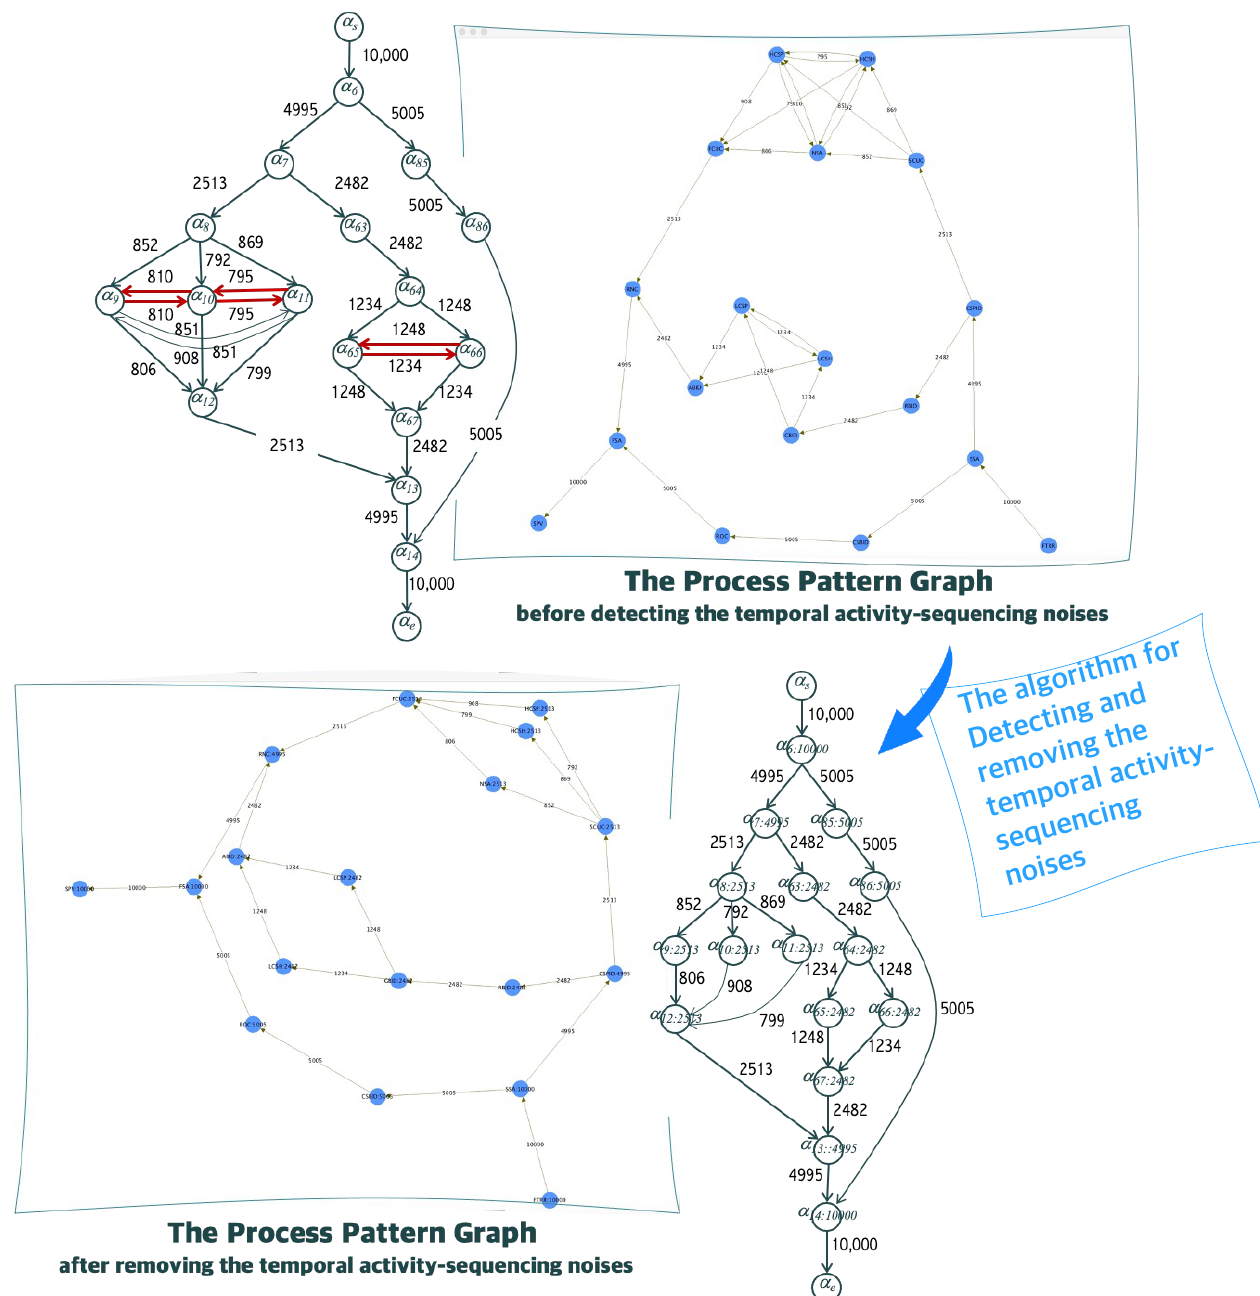
Figure 3. The process pattern graph models before and after removing noises from the dataset of 1000-all-synthetic-150MB.xes